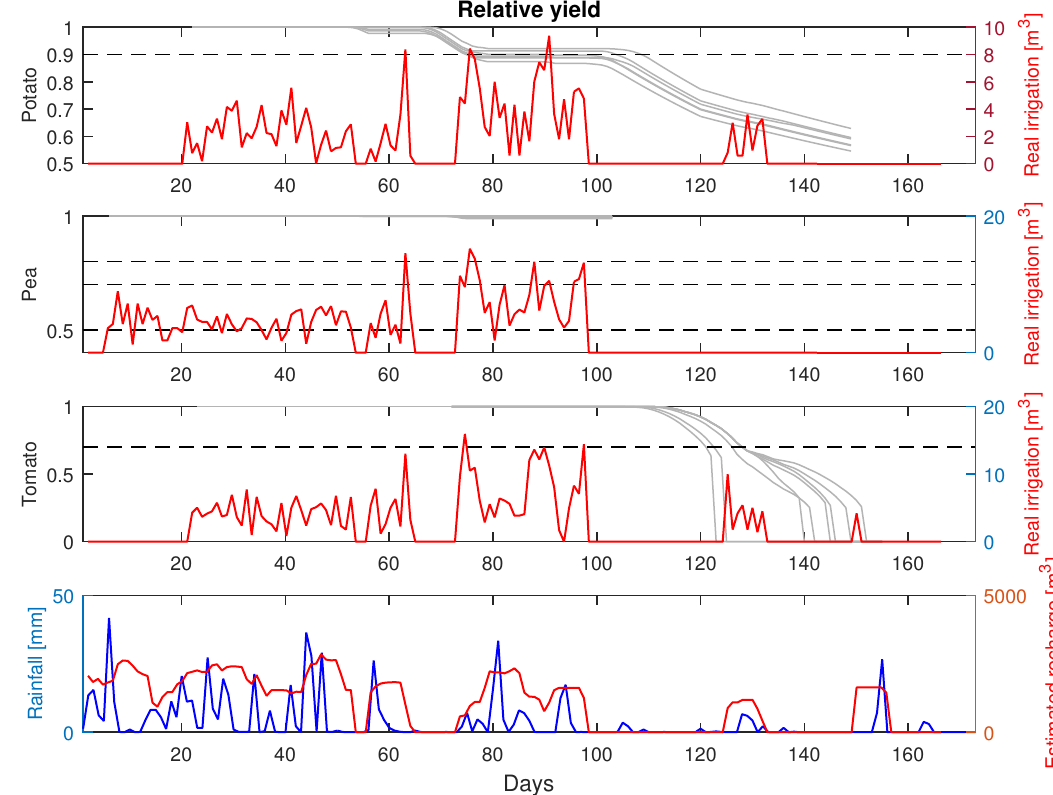
Figure 7. EWMS for crop yields, irrigation, rainfall, and estimated recharge for the baseline scenario ( S 0 ). The left y-axis in the potato, pea, and tomato plots indicates the relative yield of the different crops (gray) and their expected relative yields (dashed line), and the right y-axis indicates the irrigation (red). The fourth plot shows the measured rainfall (blue) and the estimated recharge